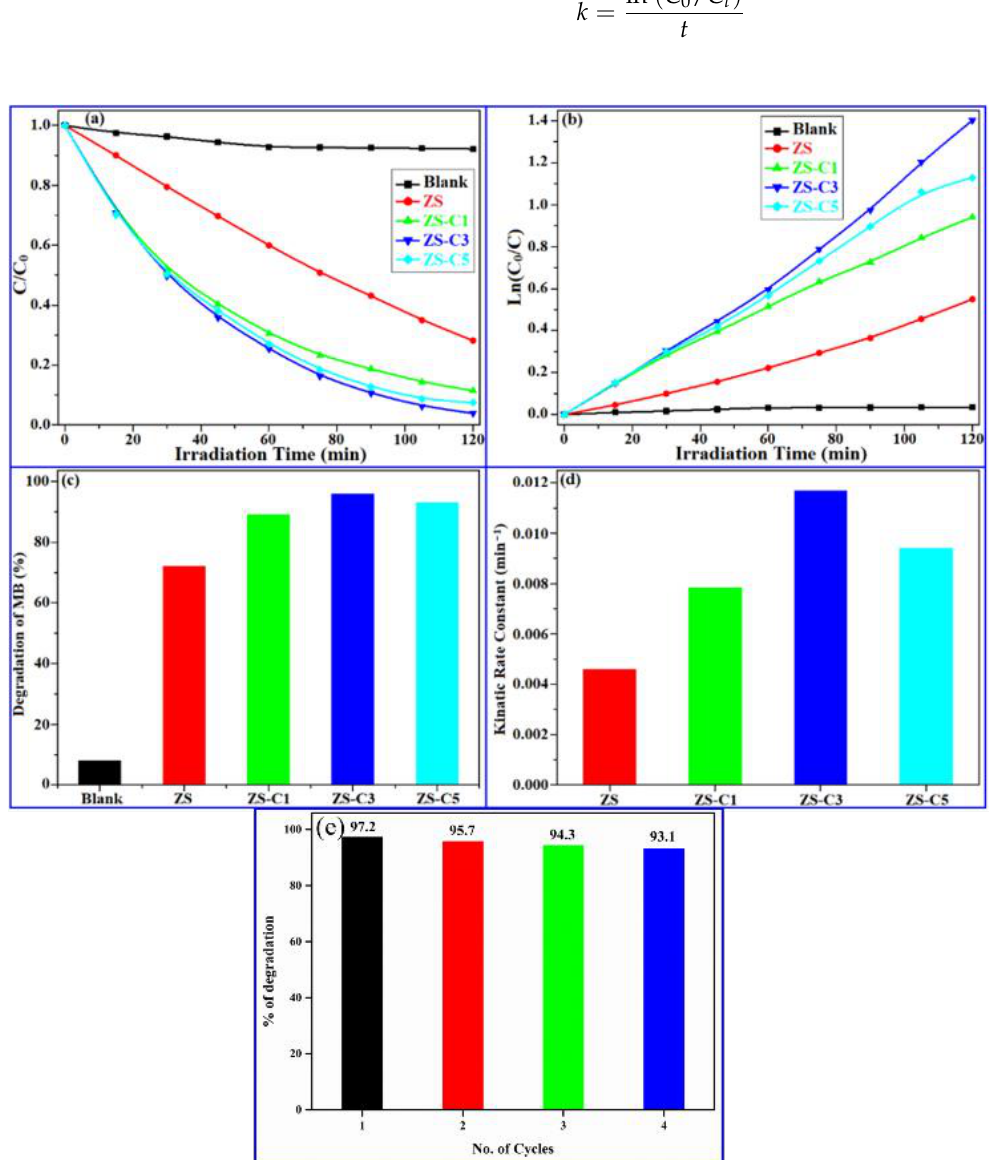
Figure 5. Photocatalytic activity of undoped and Cu 2+ -doped ZnO–SnS nanocomposites: ( a ) concentration, ( b ) kinetics for the MB dye, ( c ) degradation efficiency, ( d ) kinetic rate constants of the catalysts, and ( e ) reusability test of ZS-C3 under solar light illumination.